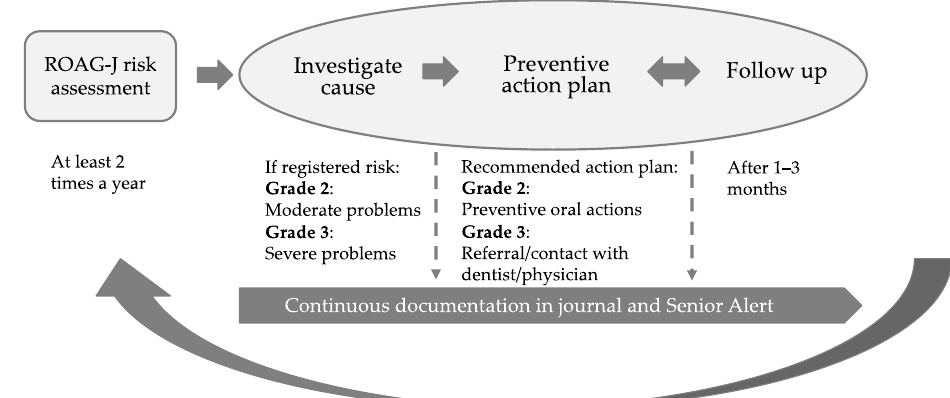
Figure 1. The preventive care approach for oral health (ROAG-J) in Senior